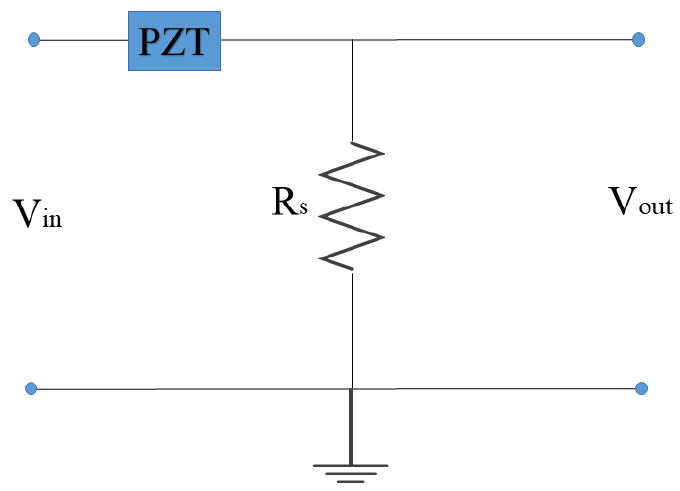
Figure 2. Circuit for calculating the PZT impedance.